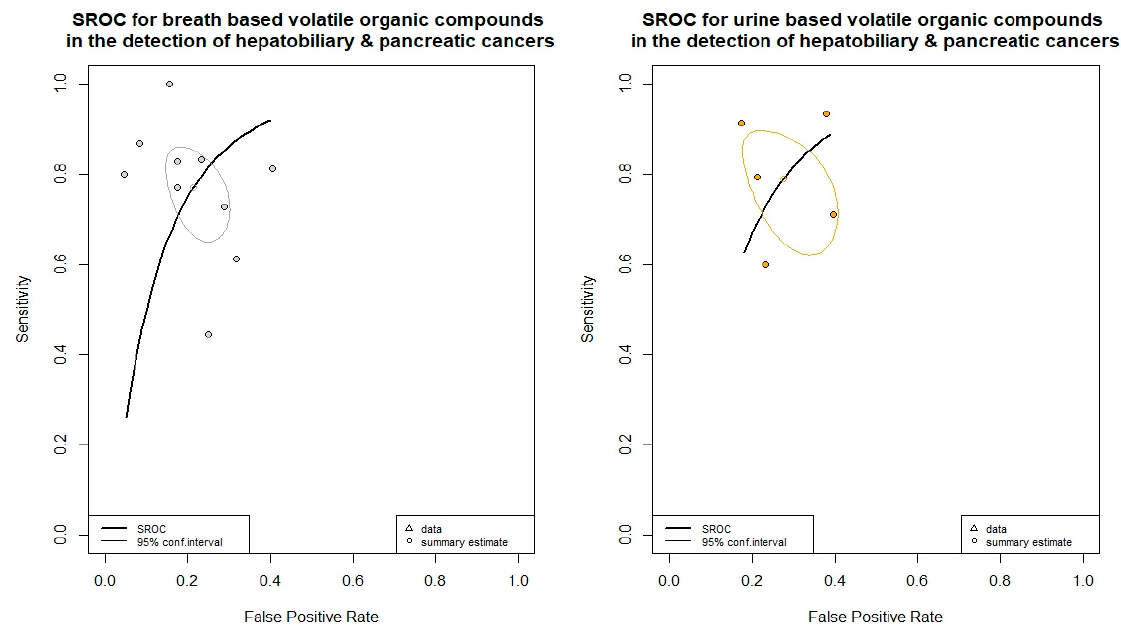
Figure 4. Summary receiver operator curve characteristics for breath and urine-based volatile organic compounds in the detection of hepatobiliary and pancreatic cancer. The circles represent the confidence interval, and the dots represent the distribution of studies.